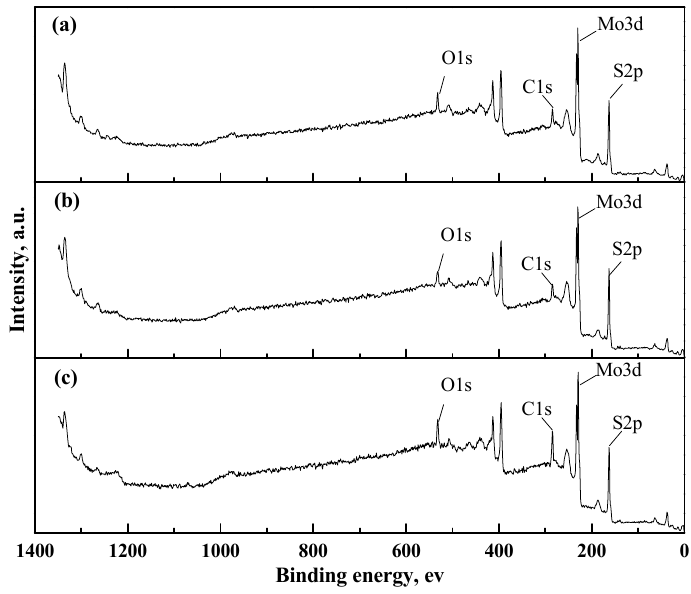
Table 4. Surface chemical composition of coal samples (semiquantitative).